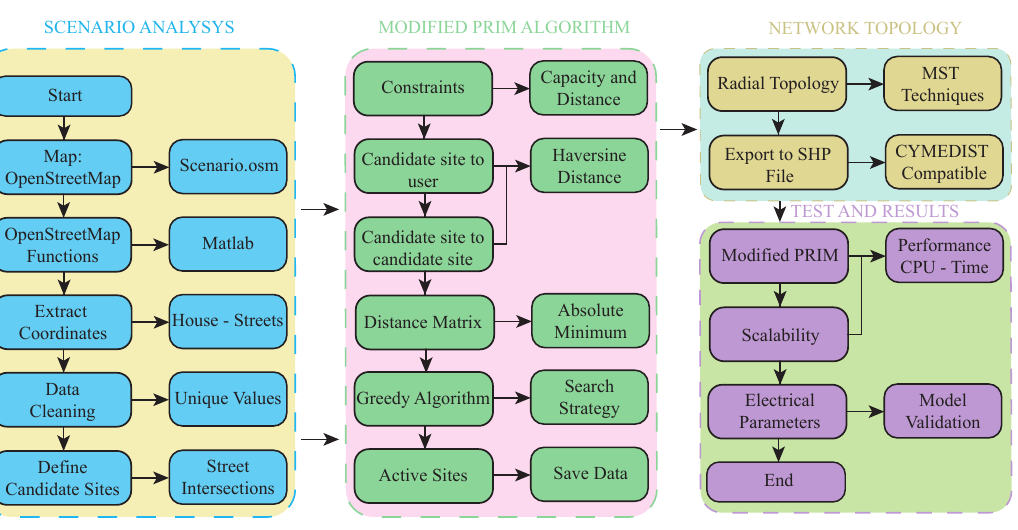
Figure 3. Methodological flowchart for the reconfiguration and resilience of power grids based on graph